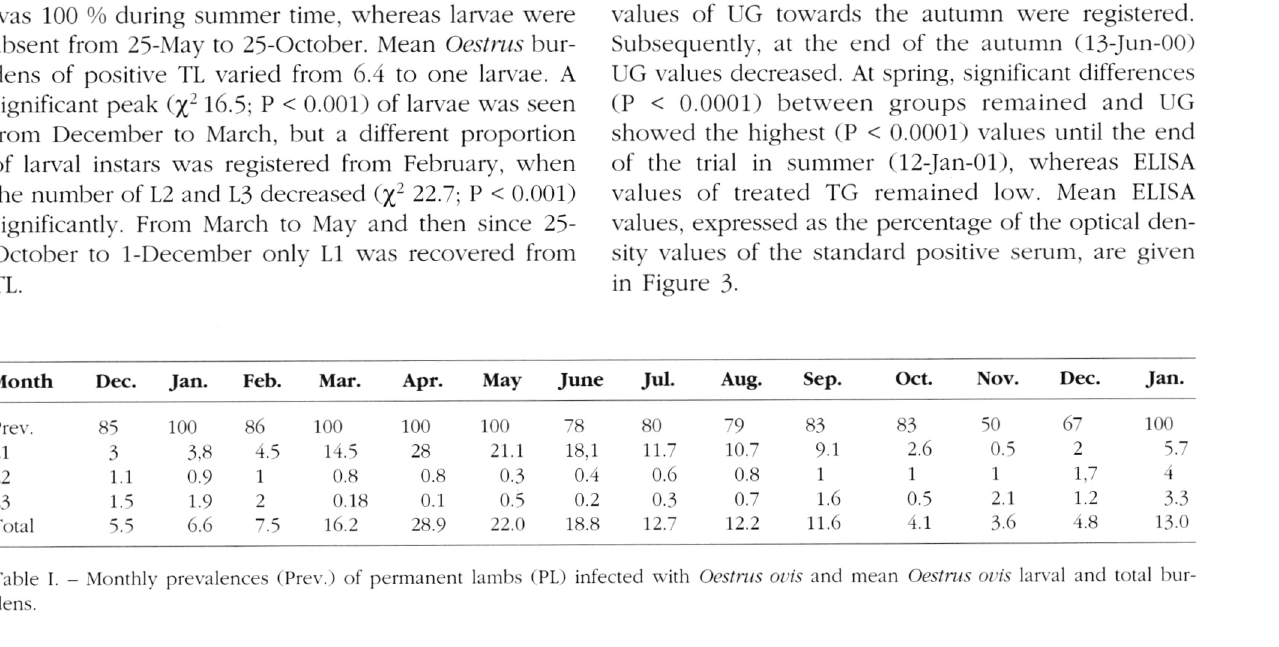
N asal discharge The arithmetic means of nasal discharge scores of both groups along the trial are showed in Figure 2. The number of ewe lambs without nasal discharges of the UG was always lower than those of the TG group. The nature of the discharge founded in the latter group was mainly serous, whereas the frequency of sero- mucous and purulent nasal discharges was high in the UG group. Since February to the middle of the sum­ mer, the nasal discharges mean scores of UG were always higher (P < 0.001) than those registered in the TG group. A ntibody (ELISA levels) No significant differences in ELISA values of both groups were observed at the start of the blood sam­ plings at the middle of the summer (09-Feb-00). The­ reafter, significant increases (P < 0.0001) of ELISA values of UG towards the autumn were registered.